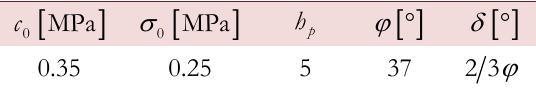
Table 2: interface